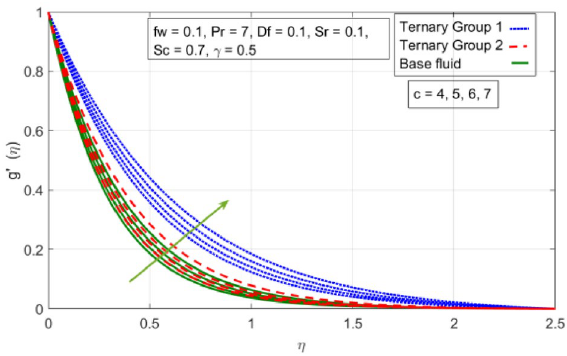
Figure 3. Variation in velocity profile against stretching ratio (c) along y-axis.